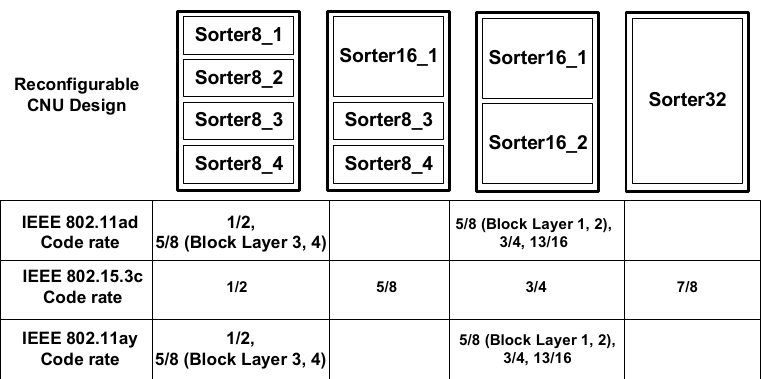
Figure 24. The configuration of the sorter under different code rates for each standard.